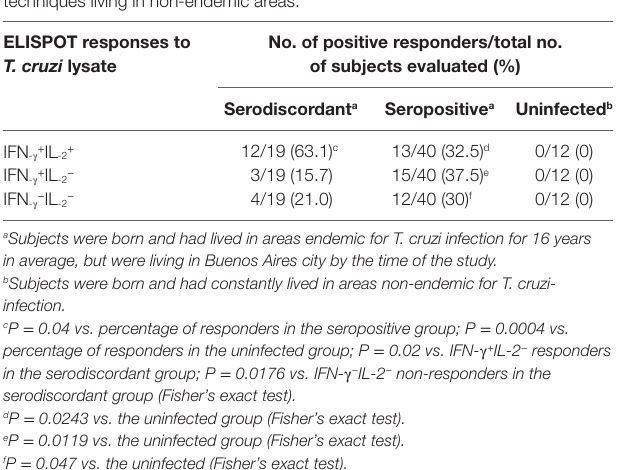
FigUre 1 | Number of interferon (IFN)- γ and interleukin (IL)-2-spot forming cells (SFCs) in response to Trypanosoma cruzi antigens in serodiscordant and seropositive subjects for T. cruzi infection. Peripheral blood mononuclear cell (PBMC) were stimulated with a T. cruzi lysate from the Brazil strain or media alone for 16–20 h. Each symbol represents the mean spot number of triplicate wells for each subject with positive IFN- γ (circles, left Y axis) or IL-2 (triangles, right Y axis) enzyme-linked immunosorbent spot (ELISPOT) responses, as defined in material and methods. Spot counts with media alone were subtracted. horizontal lines depicting median values are shown. Significant differences between subject groups were determined by Mann–Whitney U test.